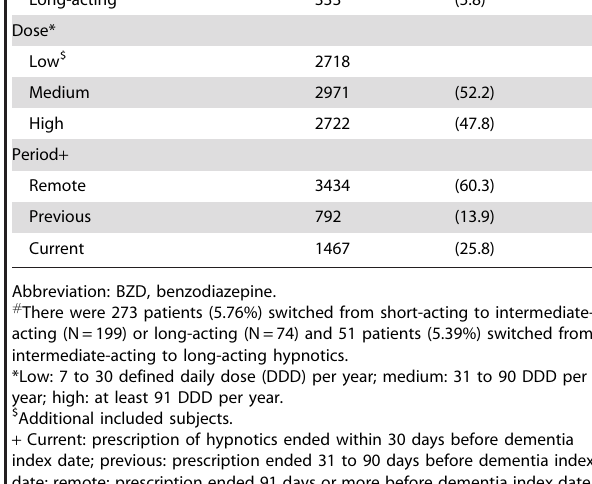
Abbreviation: BZD, benzodiazepine. # There were 273 patients (5.76%) switched from short-acting to